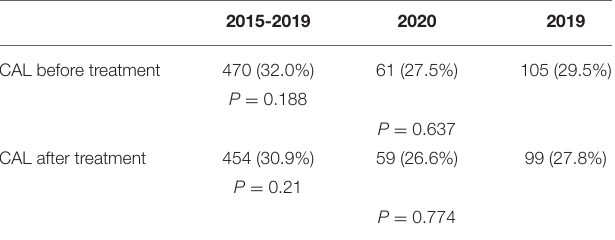
TABLE 4 | The comparision of CAL incidence.